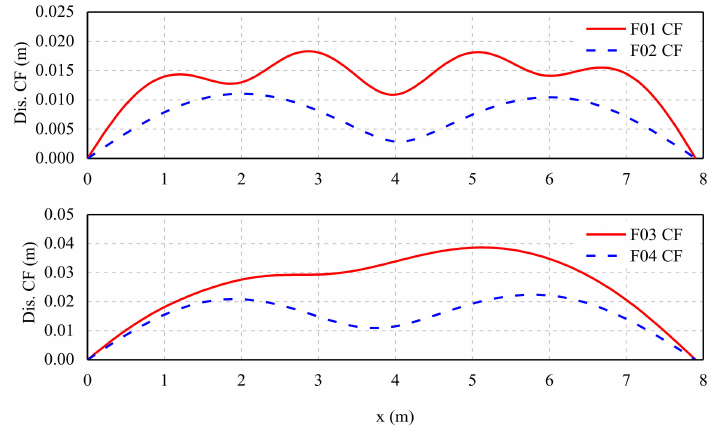
Figure 7. Axial distribution of RMS value of VIV displacement under uniform flow (1.6 m/s).